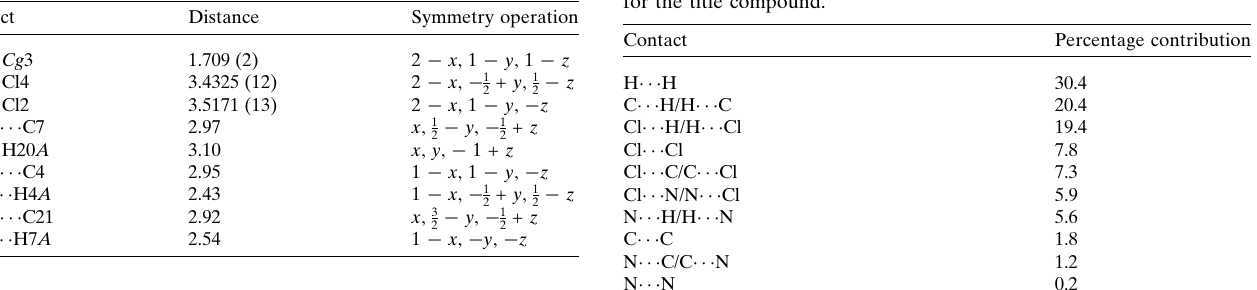
Table 3 Percentage contributions of interatomic contacts to the Hirshfeld surface for the title compound.